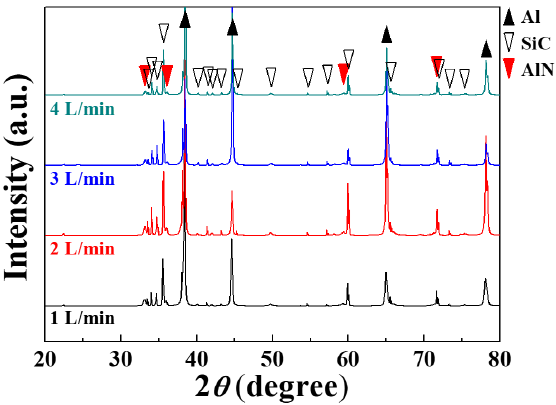
Figure 4. XRD patterns of 20 vol% SiC (40 μ m)/Al 6061 composites produced by heating for 1 h at 640 °C under various flow rates of nitrogen gas.